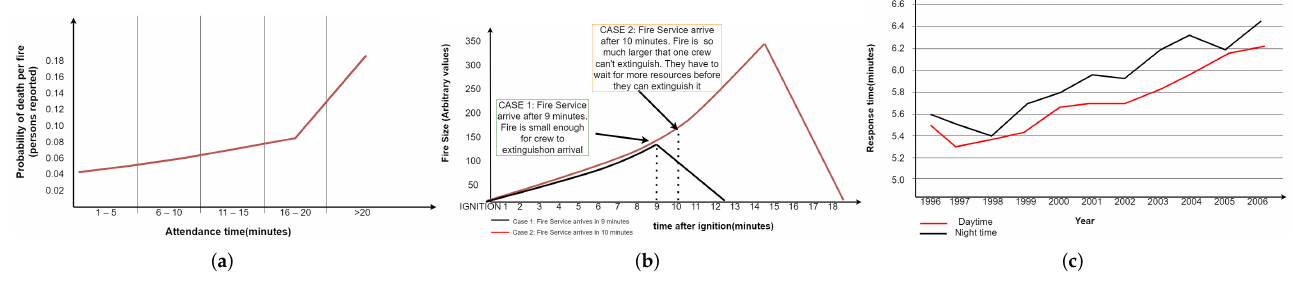
Figure 1. Revealing historical data of the evolution in fire detection and the relevance of response time with survival. ( a ) Relationship between fire death and the exposure time of fire appliances; ( b ) effect of a small increased exposure time; ( c ) day and night time dwelling fire response times